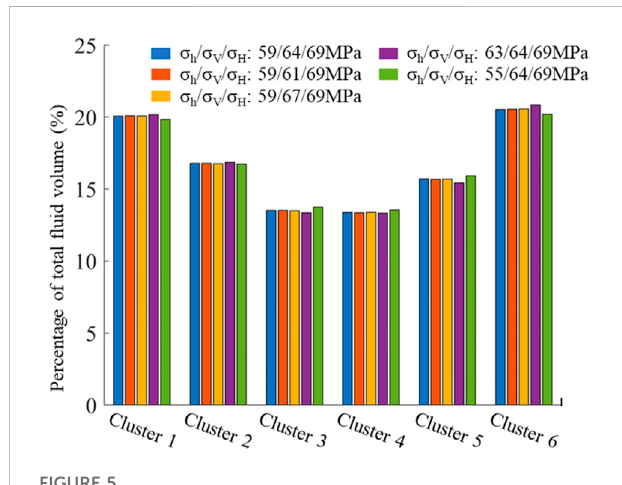
FIGURE 5 Thetotal fl uidvolumedistributionofeachclusterfor fi vecaseswith different in-situ stress combination